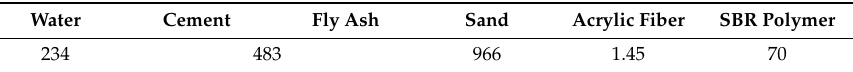
Table 2. PCM mixture proportion (kg / m 3 ).